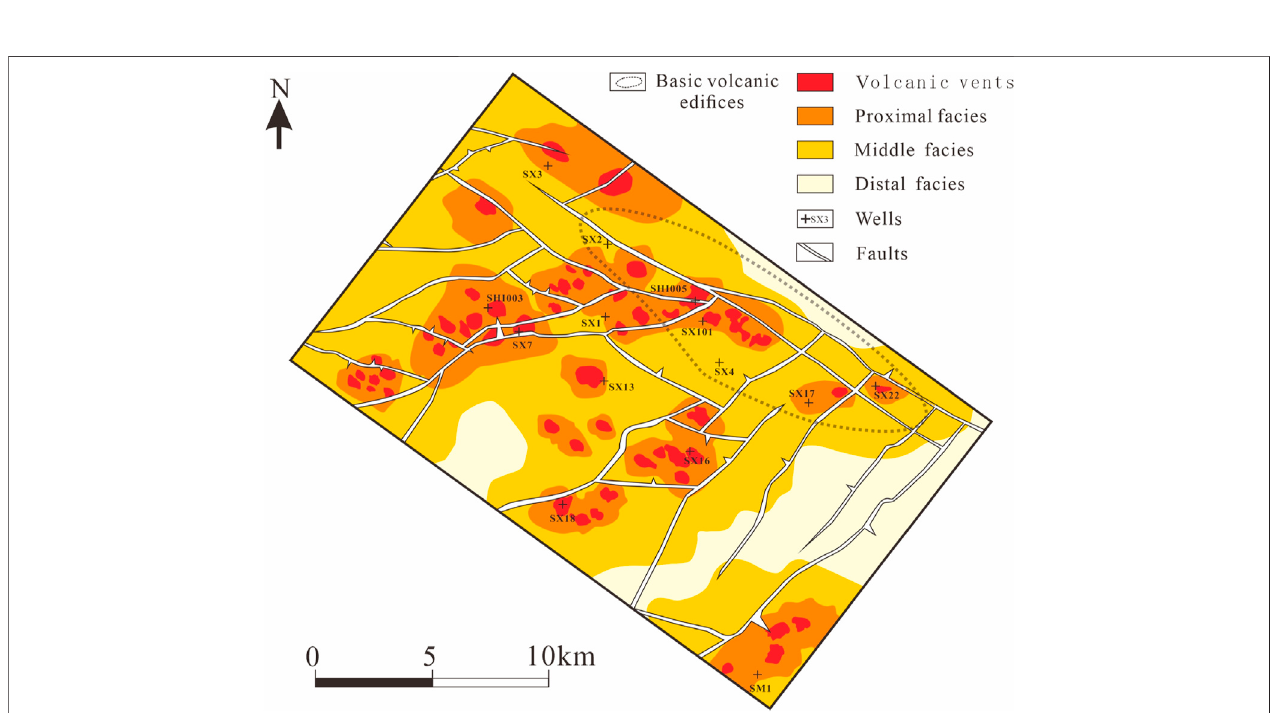
FIGURE 5 | Distribution of upper Carboniferous volcanic edi fi ces in the study area.